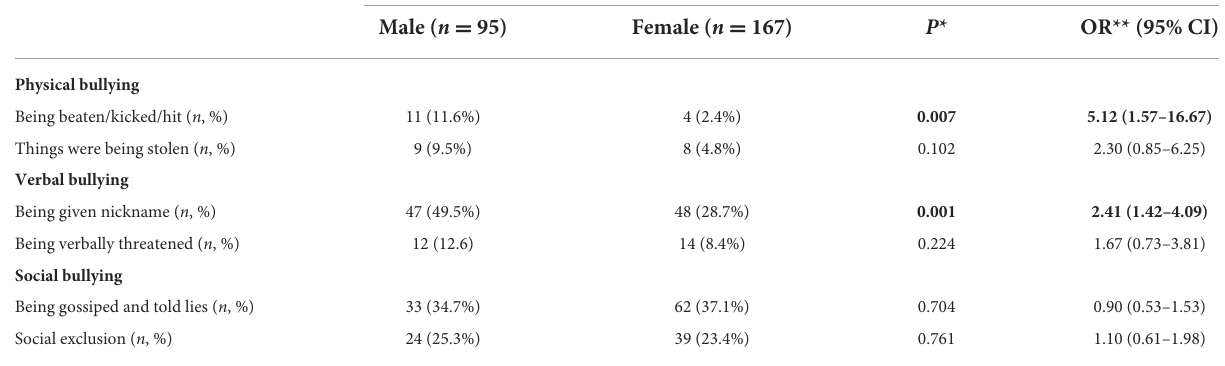
TABLE 2 Comparison of high school bullying experiences by gender. Bullying subtypes